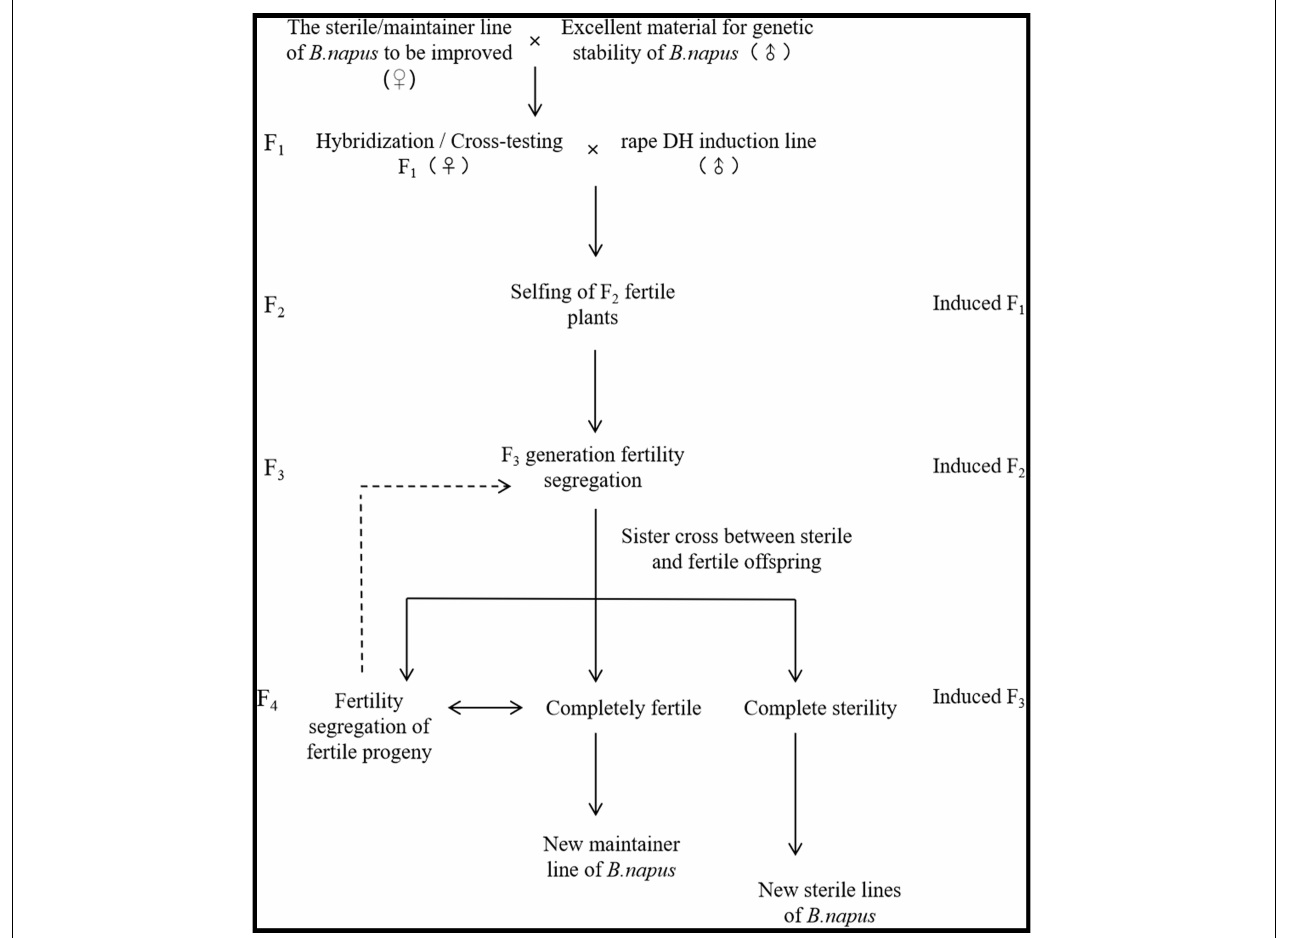
FIGURE 6 | Model diagram of rapid synchronous breeding of maintainer sterile